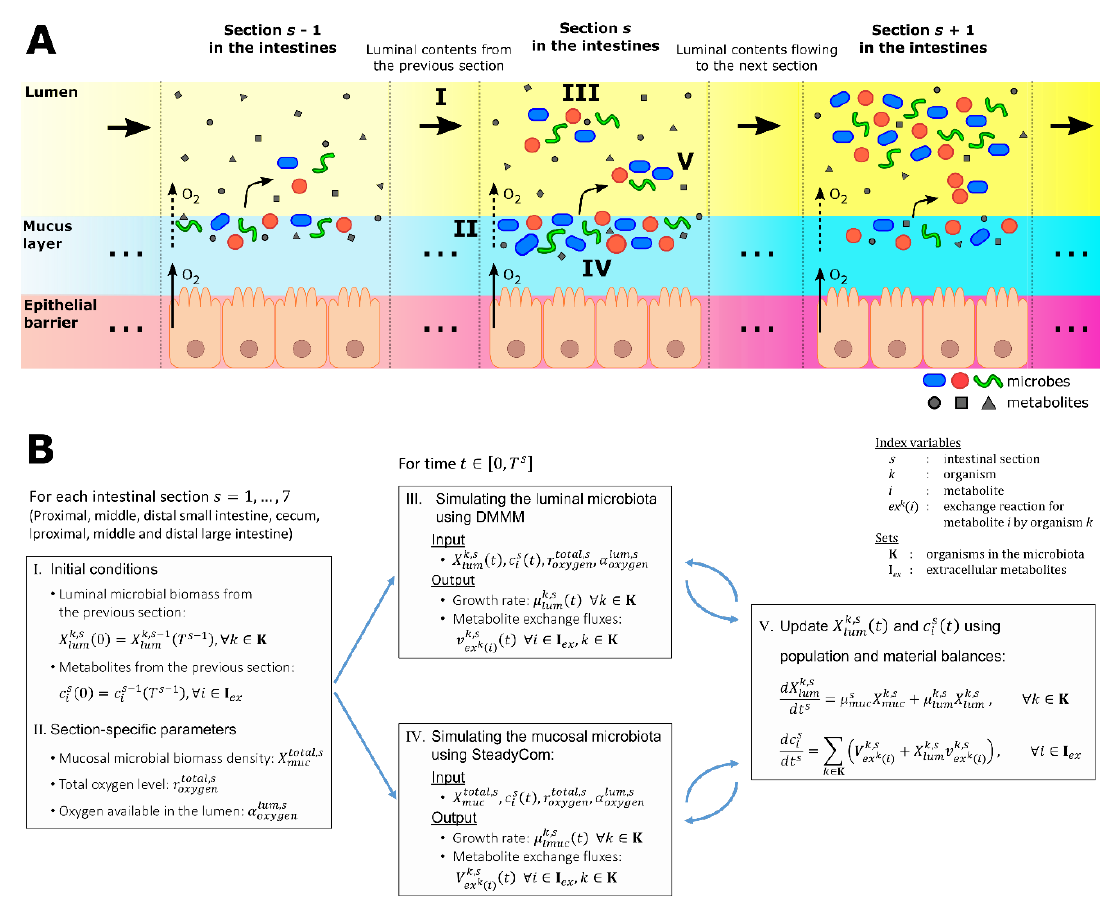
Figure 1. Proposed dynamic framework for predicting the mucosal and luminal microbiota along various sections of the intestines. ( A ) Five processes being modeled in each section: (I) the luminal contents at the beginning of the simulation for each section are equal to the luminal contents at the end of the simulation for the previous section. Metabolites in the luminal contents shared freely by the mucosal and luminal microbiota, (II) oxygen diffused from intestinal epithelial cells to the mucus layer and further to the lumen, (III) the metabolism and abundance profile of the luminal microbiota predicted using DMMM, (IV) the metabolism and abundance profile of the mucosal microbiota predicted using SteadyCom, (V) newly produced mucosal microbial biomass shed into the lumen and becoming luminal biomass. ( B ) The corresponding simulation procedure. The luminal and mucosal microbiota in each section use the same copy of community metabolic network structure consisting of the organisms listed in Table 1.